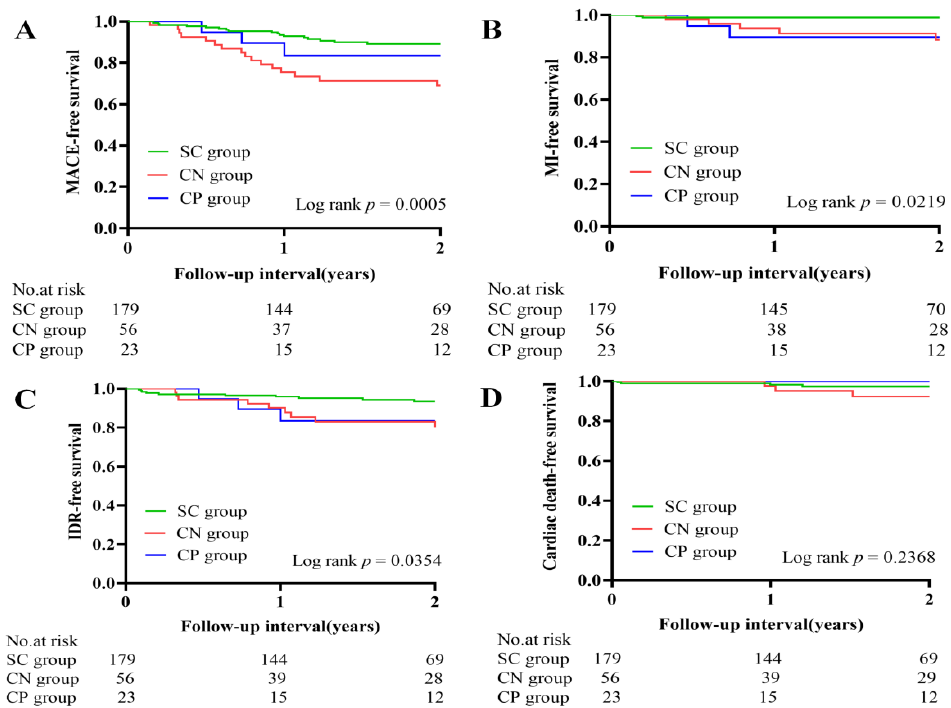
Figure 3. Kaplan–Meier survival curves of clinical outcomes. ( A ) MACE-free survival; ( B ) target vessel myocardial infarction-free survival; ( C ) ischemia-driven revascularization-free survival; ( D ) cardiac death-free survival. MACE, major adverse cardiac events; MI, myocardial infarction-free survival; IDR, ischemia-driven revascularization.